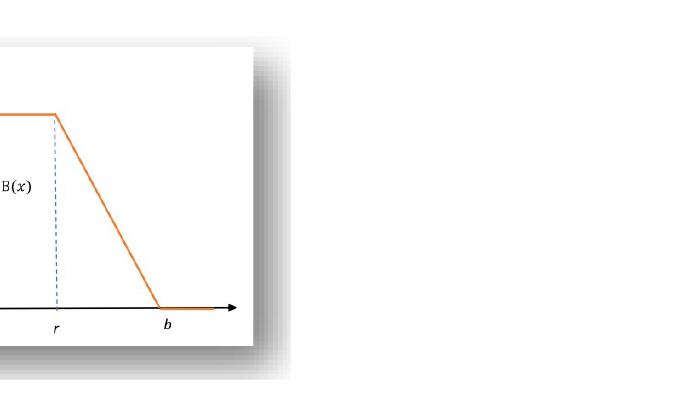
Figure 4. The trapezoidal fuzzy number created via the cumulative uniform distribution func- tion F ( x ) .